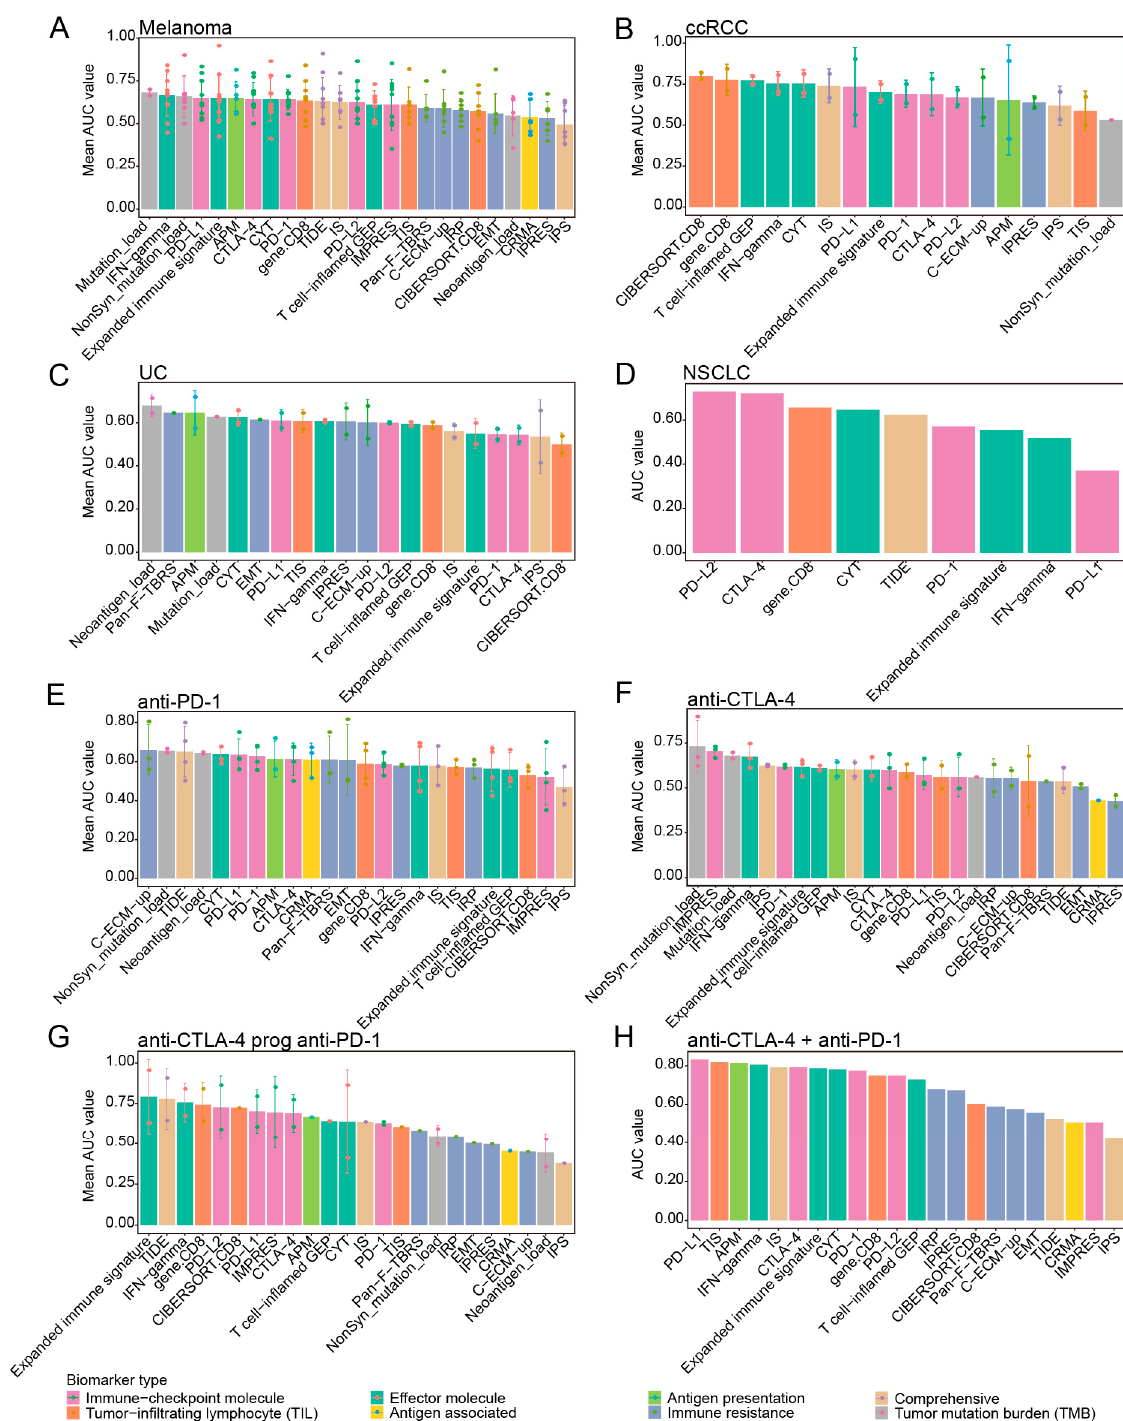
Figure 5. Prediction performance of biomarkers for ICB response across different cancer types and different ICB therapy strategies. ( A – D ) Bar centre was defined by the mean AUC values of each transcriptomic biomarker across different cancer datasets (patients stratification using “PD” strategy), and error bars indicated ±1 SD. ( E – H ) Bar centre was defined by the mean AUC values of each transcriptomic biomarker in melanoma datasets under different ICB therapy strategies (patients stratification using “PD” strategy), and error bars indicated ±1 SD.